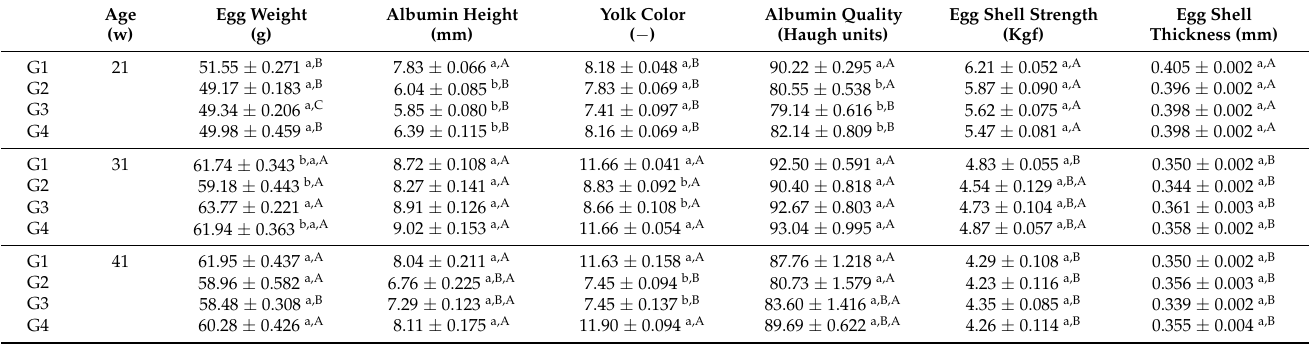
Table 2. Egg quality of Salmonella -challenged and unchallenged laying hens with or without Allium -based phytobiotic supplementation.